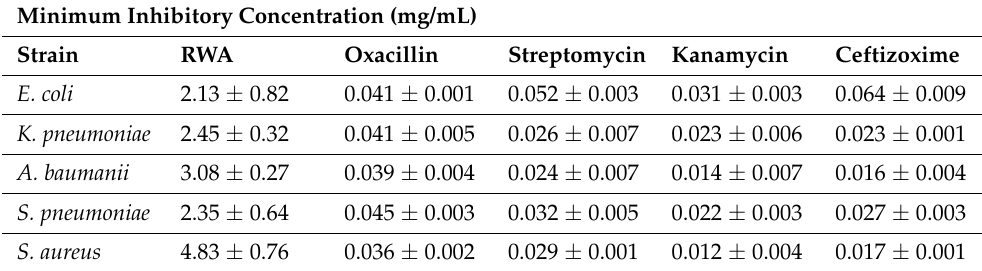
Table 4. MIC values of RWA tested against bacterial strains. Minimum Inhibitory Concentration (mg/mL) Strain RWA Oxacillin Streptomycin Kanamycin